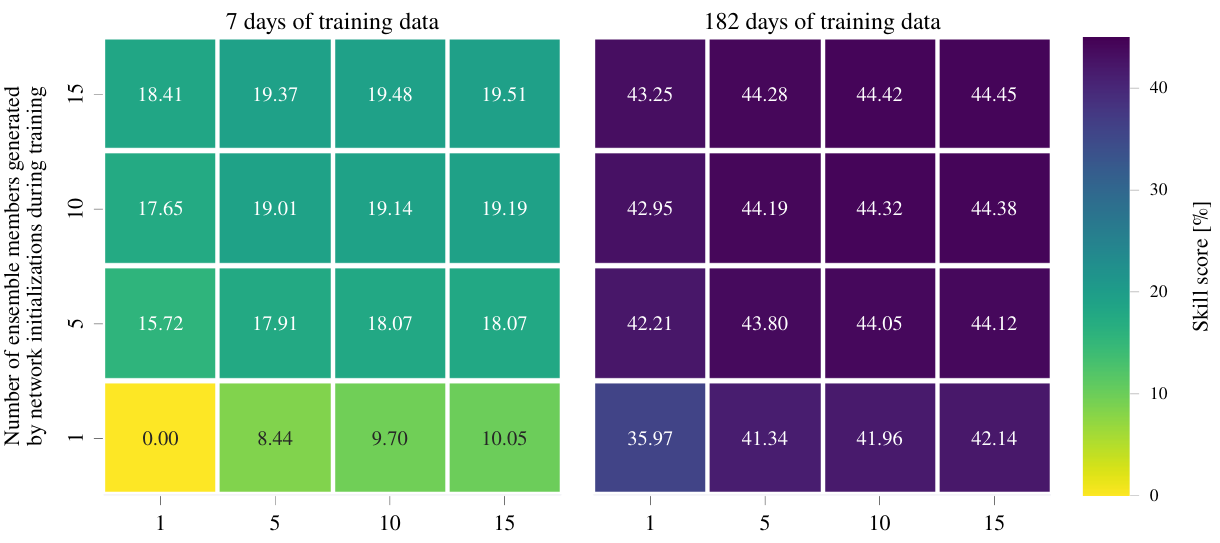
Figure 8. Influence of the number of MC dropout members and network initializations during training on the forecast quality depending on the amount of available training data. The data include all forecasts over the entire horizon (six hours) with ten mixed distributions. To enable a clearer analysis of the benefits of the epistemic extensions, the prediction with one dropout member and one initialization member was used as a reference value for the skill